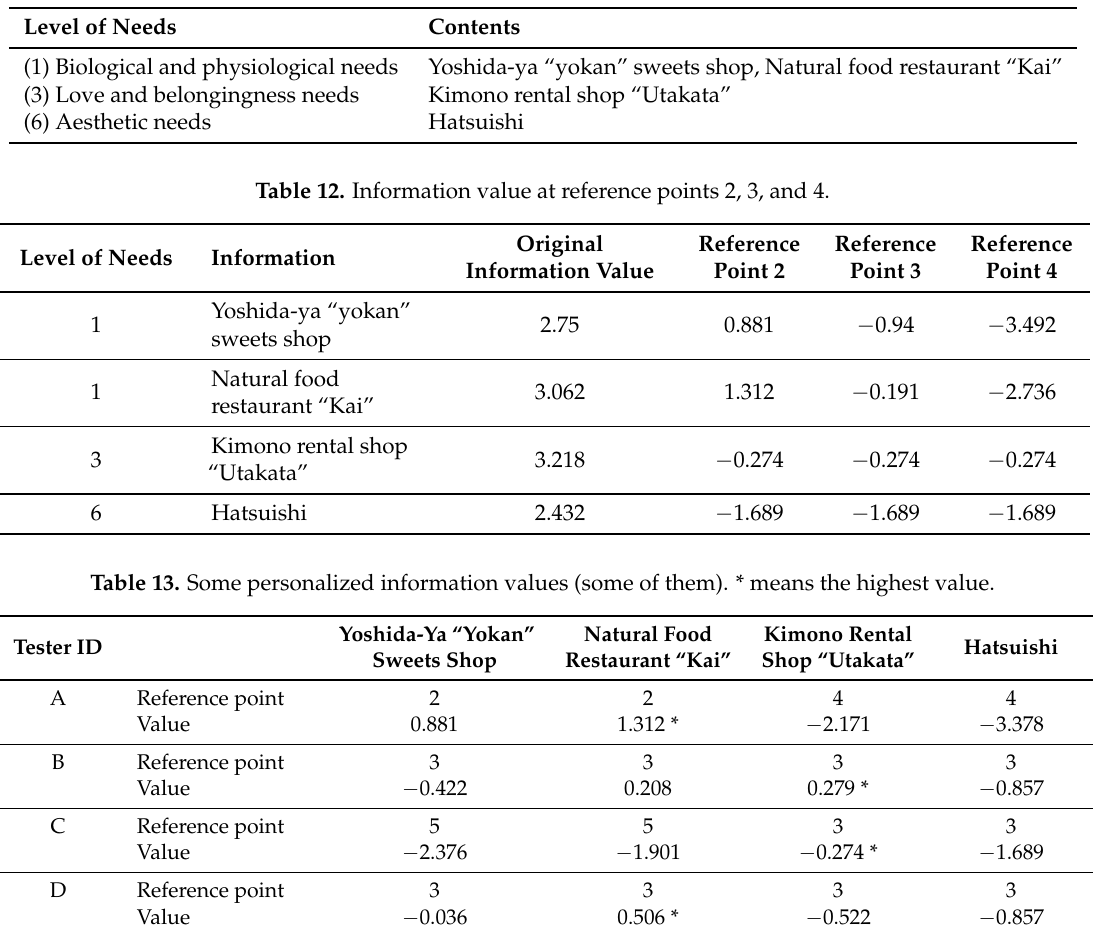
Table 11. Parameters of simulation.